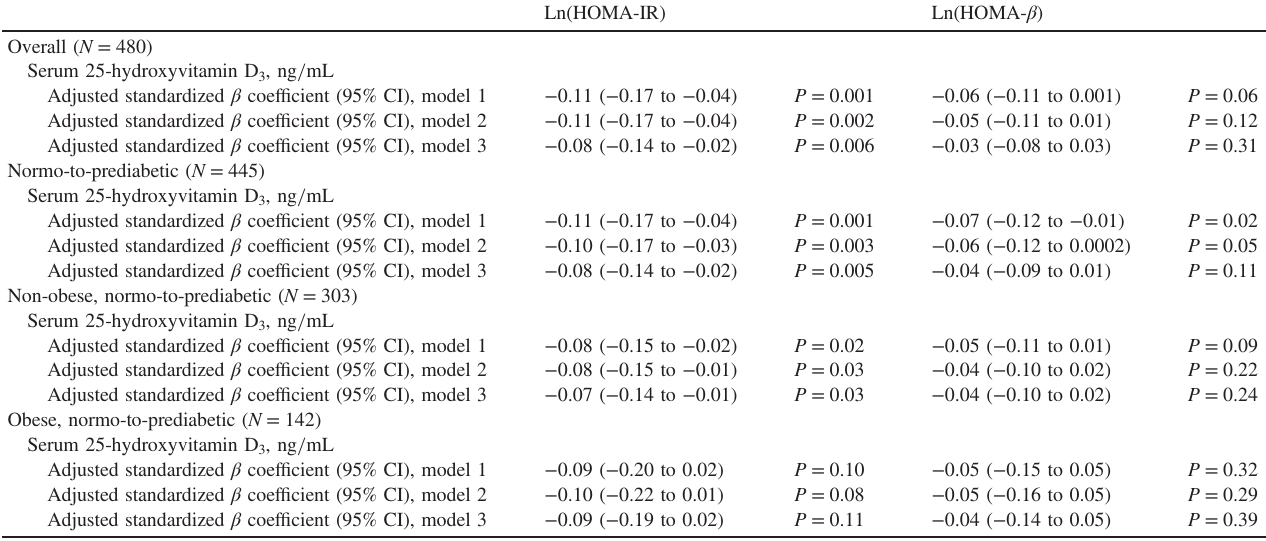
Table 4. Standardized β coe ffi cients between serum 25-hydroxyvitamin D 3 and ln(HOMA-IR) and ln(HOMA- β ) in the study population Ln(HOMA-IR) Ln(HOMA- β ) Overall ( N = 480) Serum 25-hydroxyvitamin D 3 , ng / mL Adjusted standardized β coe ffi cient (95% CI), model